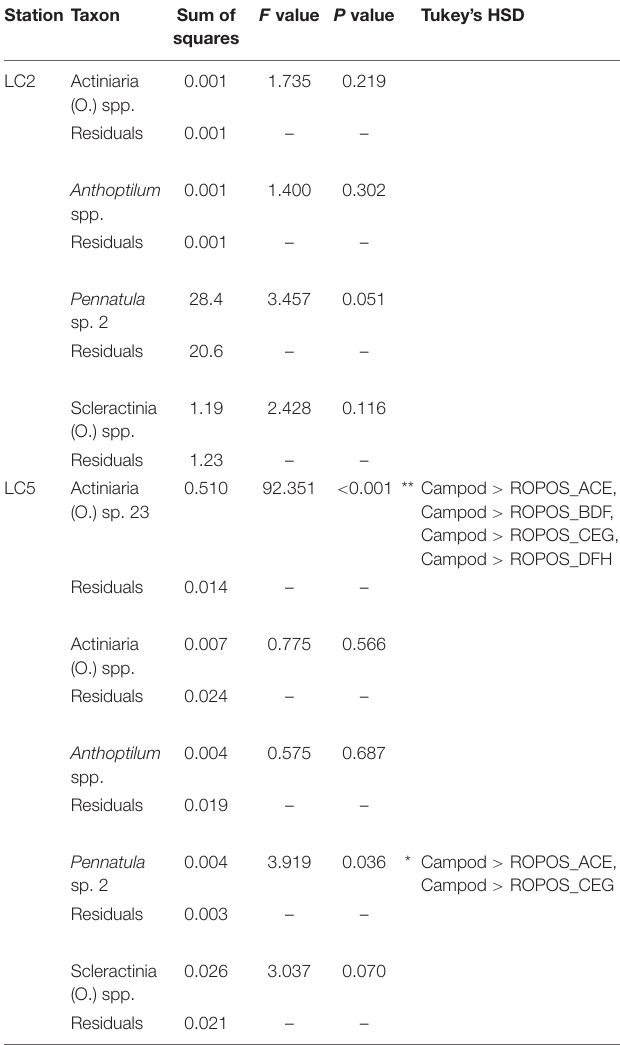
TABLE 5 | One-way ANOVAs (type 2) on untransformed data, using five fixed levels of design: Campod, ROPOS_ACE, ROPOS_BDF, ROPOS_CEG, and ROPOS_DFH (3 400 m transects) for abundant taxa (present in at least 11 of 22 total transects), at stations LC2 and LC5 in the Laurentian Channel